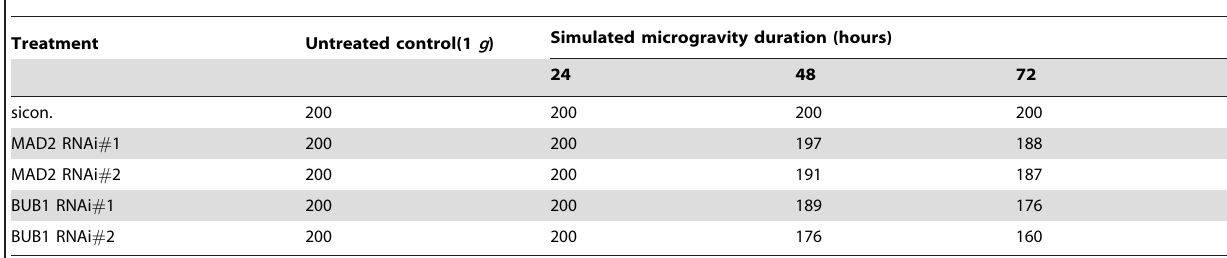
Table 1. FL2-A position of G1 peak under simulated microgravity (nm).